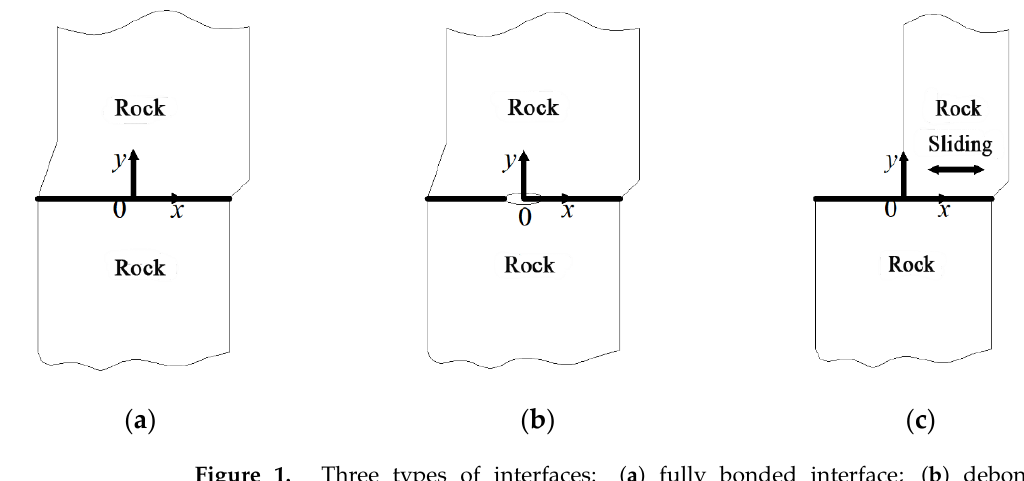
Figure 1. Three types of interfaces: ( a ) fully bonded interface; ( b ) debonding interface; ( c ) contact interface.